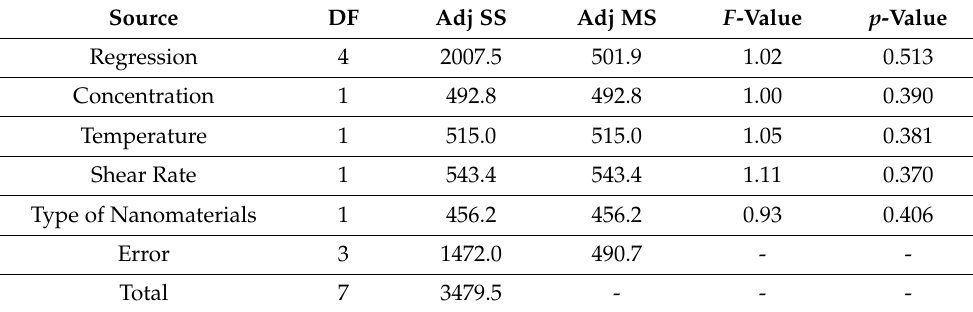
Table 4. Analysis of variance (viscosity).